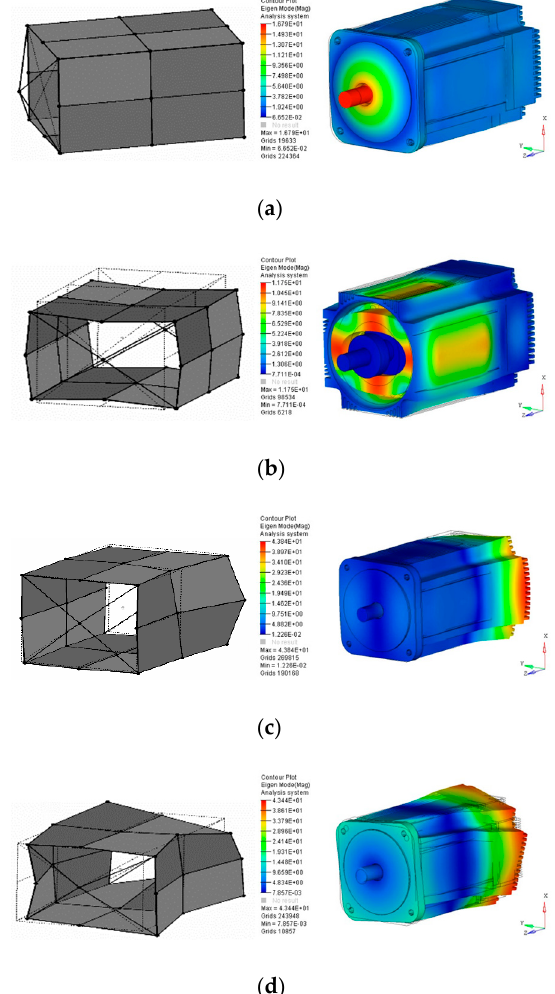
Figure 6. Results of the modal test (left) and modal analysis (right). ( a ) 1st mode; ( b ) 2nd mode; ( c ) 3rd mode; ( d ) 4th mode.